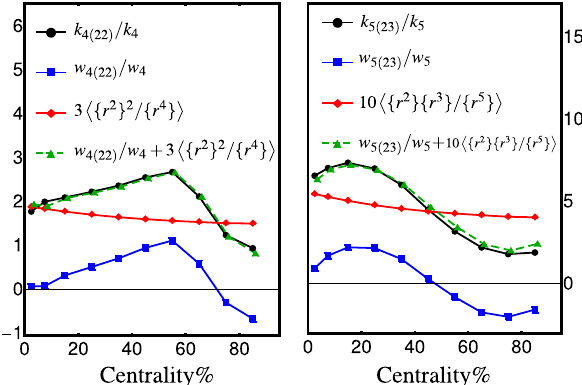
Fig. 4 The T R ENTo initial state radial shape (diamond points), and the nonlinear over linear hydrodynamic response couplings from VISH2+1 + UrQMD (circle and square